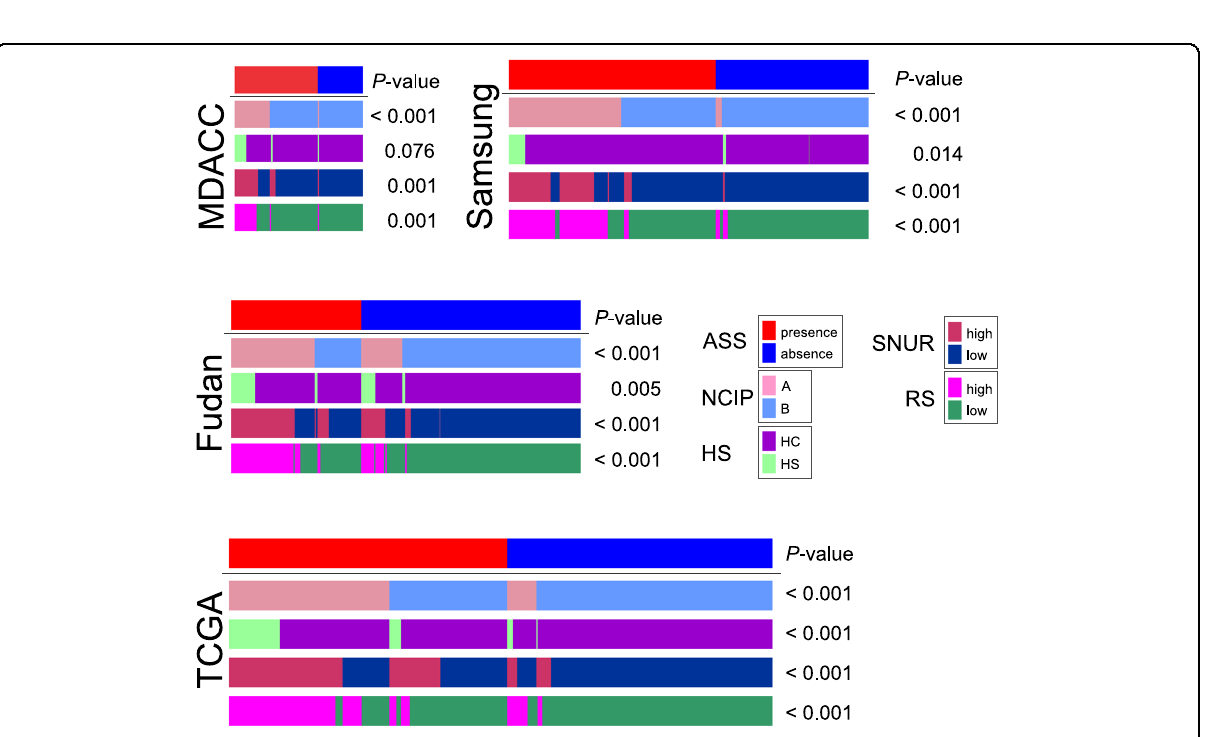
Fig. 4 Association of the APOB-silenced signature with previously identi fi ed molecular subtypes of hepatocellular carcinoma. The signi fi cance of the associations was assessed using a χ 2 test. ASS APOB-silenced signature, NCIP National Cancer Institute proliferation, HS hepatic stem cell (HS or hepatocyte [HC]), SNUR Seoul National University recurrence, RS recurrence-risk